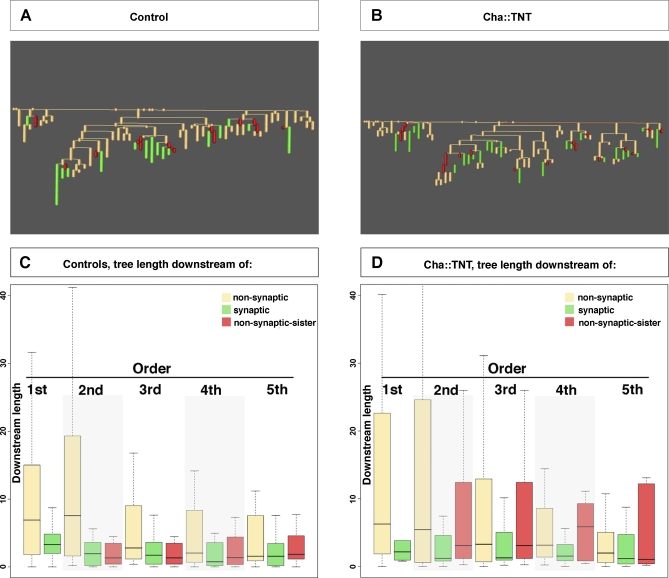
Synaptic Activity Locally Inhibits Postsynaptic Dendritic Arbor Extension(A and B) Dendritograms of a representative arbor from a control (A) and a Cha::TNT-G animal (B). The dendritograms depict the hierarchical branch orders of the arbors from the origin (i.e., axon, top branch) down. Neurites contacted by presynaptic sites are coloured in green, nonsynaptic sister branches in red.(C) Comparison of number of branch points downstream of other nonsynaptic neurites (non-syn) (beige); synaptic neurites (syn) (green); nonsynaptic sister neurites (non-syn-sist) (red), in control conditions. The y-axis indicates downstream tree length in micrometres; the x-axis indicates type of neurite and branch order.(D) Analysis of tree length downstream of the different types of neurites as for (C) in Cha::TNT-G animals. The y-axis indicates downstream tree length in micrometres; x-axis indicates type of neurite and branch order.Neurites are sorted by branch order, and results for the first five branch orders are shown.Box-plots show the median of the distribution (middle line), the 75th percentile (upper limit of box), and 25th percentile (lower limit of box). Whiskers extend 1.5 times the inter-quartile range; outliers are not plotted. Significance was assessed by the Wilcoxon rank-sum test. Double asterisks (**) indicate p < 0.005.